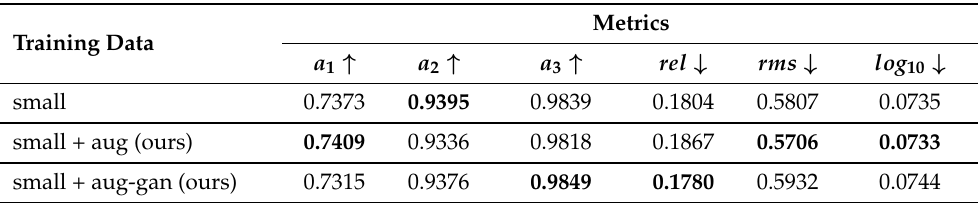
Table 4. Neural network results for estimating depth maps on NYUv2 set and its augmentations. Numbers in bold indicate the best result in the